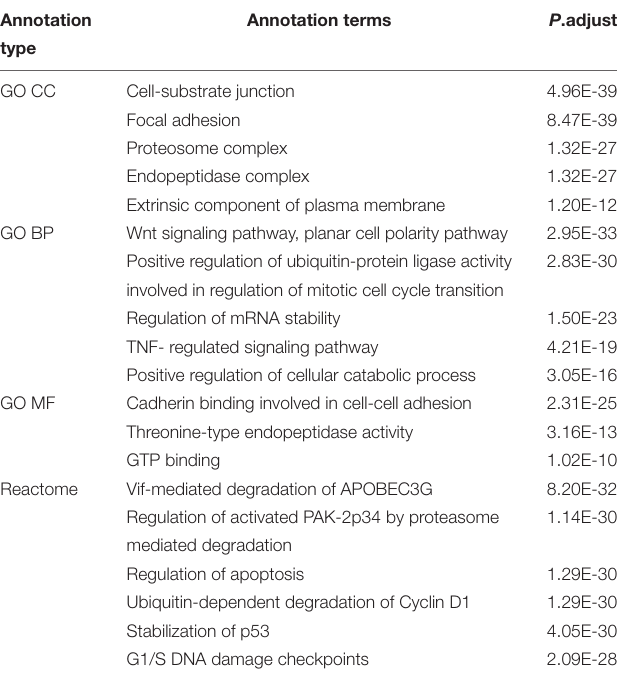
TABLE 1 | Top enrichment terms for cancer P140Cap interactome.